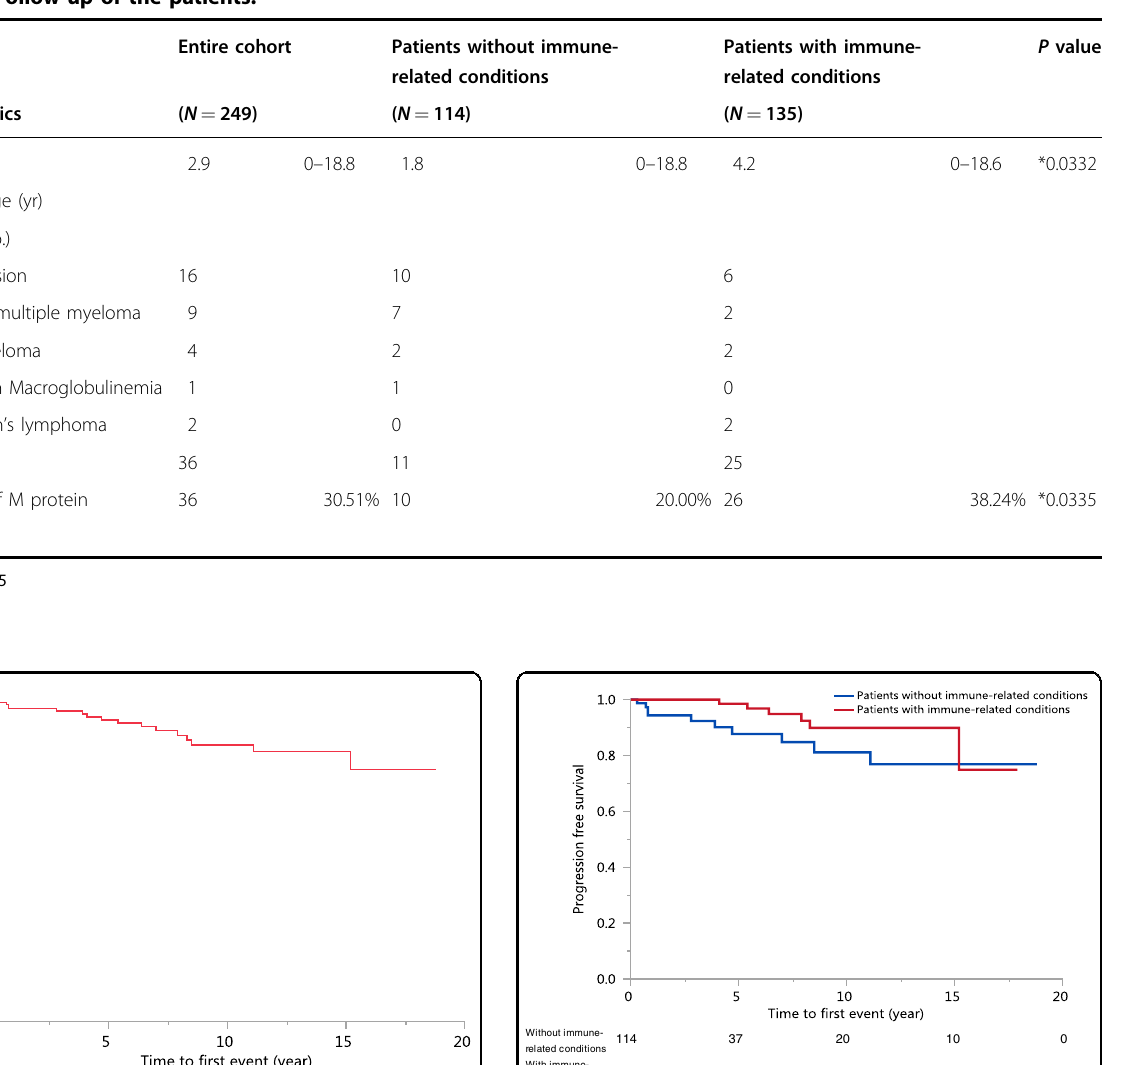
Table 4 Follow-up of the patients.